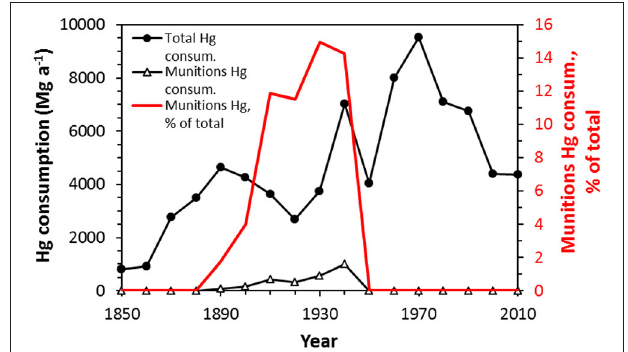
FIGURE 2 | Global annual mercury consumption, annual Hg consumption for munitions, and proportion used in munitions. Mercury-based explosives show a peak in production during the period of WWI and WWII. Redrawn after Horowitz et al.